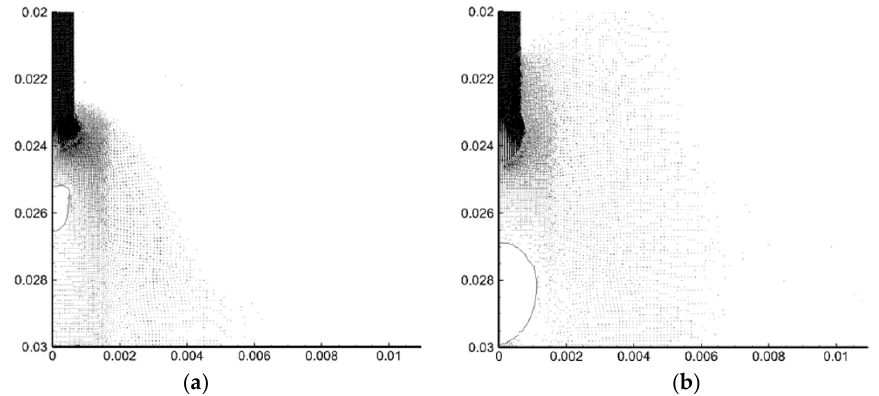
Figure 5. Current density vectors in ( a ) conventional MIG welding and ( b ) plasma – MIG welding.